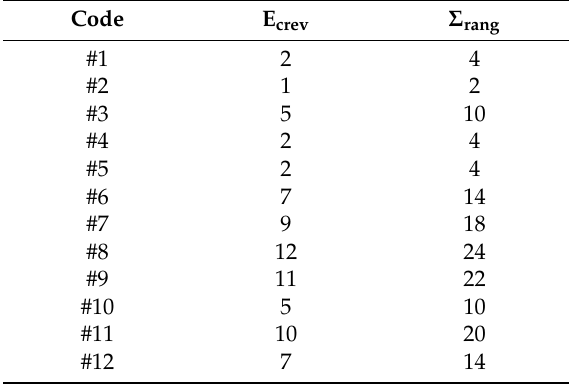
Table 6. Ranks attributed to the 12 steels according to the crevice corrosion